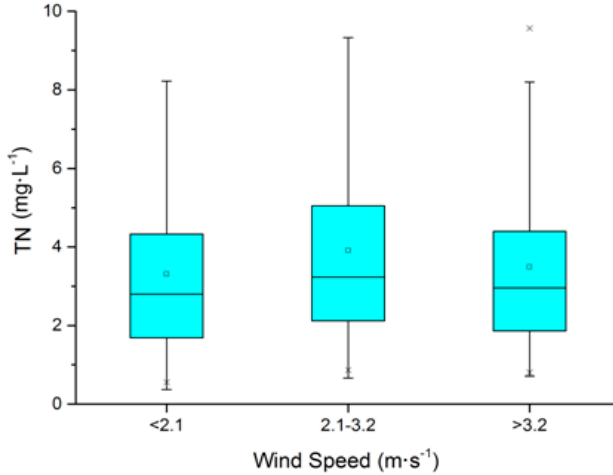
Figure 8. The whisker’s boxplot of total nitrogen (TN) concentration for the three wind speed groups.